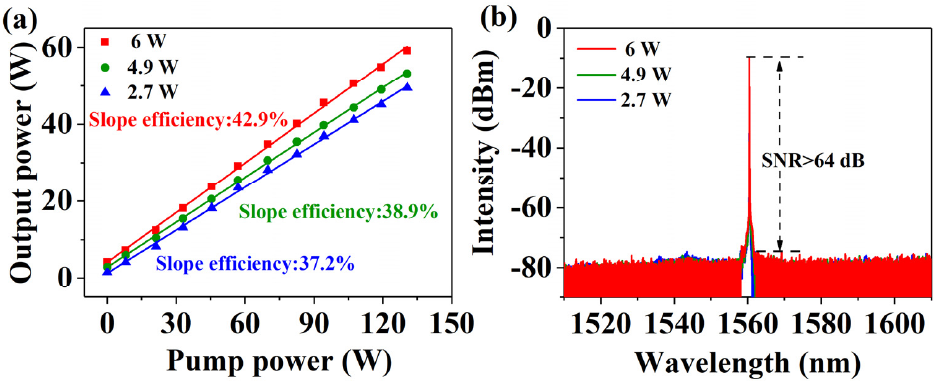
Figure 3. The system is under different input signal powers. ( a ) The output power of 1560 nm linearly- polarized SFFL versus the pump power. ( b ) The output spectrum of 1560 nm linearly-polarized SFFL under 40 W output